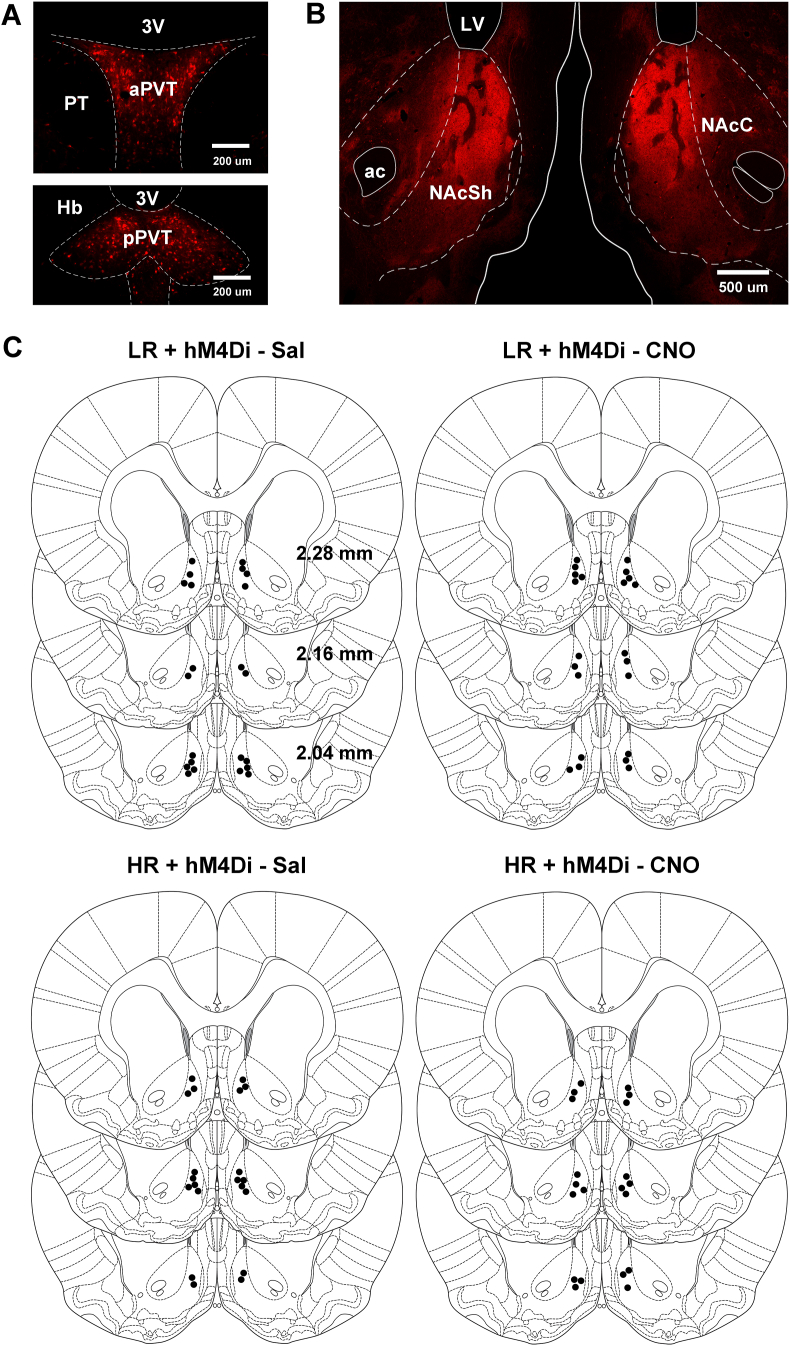
Immunofluorescence for hM4Di/mCherry and cannula placements. Representative examples of neurons in the aPVT and pPVT transduced with hM4Di/mCherry (A) and fibers in the NAcSh (B). (C) Locations of the injector cannula in the NAcSh. Scale bars: A, 200 μm; B, 500 μm. Abbreviations: 3 V, third ventricle; ac, anterior commissure; aPVT, anterior PVT; Hb, habenula; LV, lateral ventricle; NAcC, core of NAc; NAcSh, shell of NAc; pPVT, posterior PVT; PT, paratenial nucleus of the thalamus.